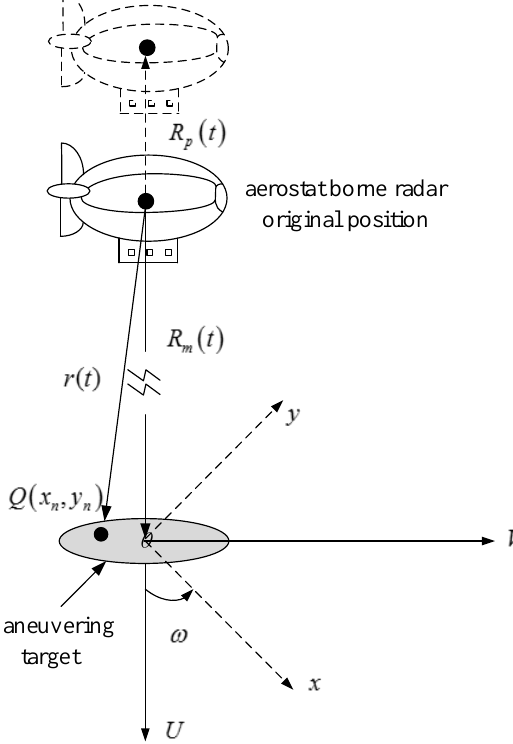
Figure 1. Aerostat borne ISAR imaging geometry model.